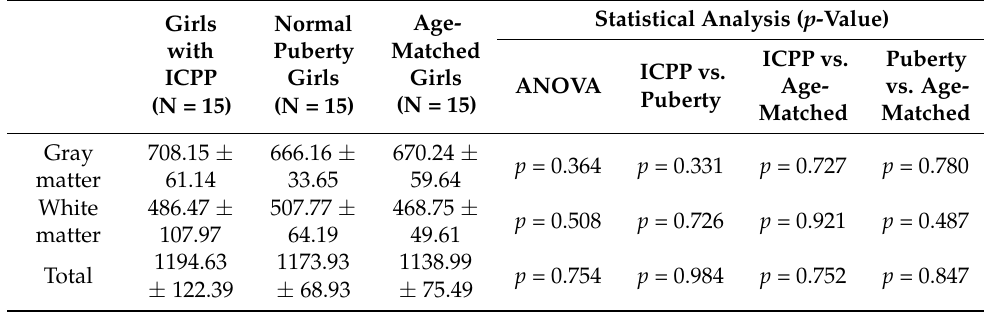
Table 1. Total intracranial volume estimates in